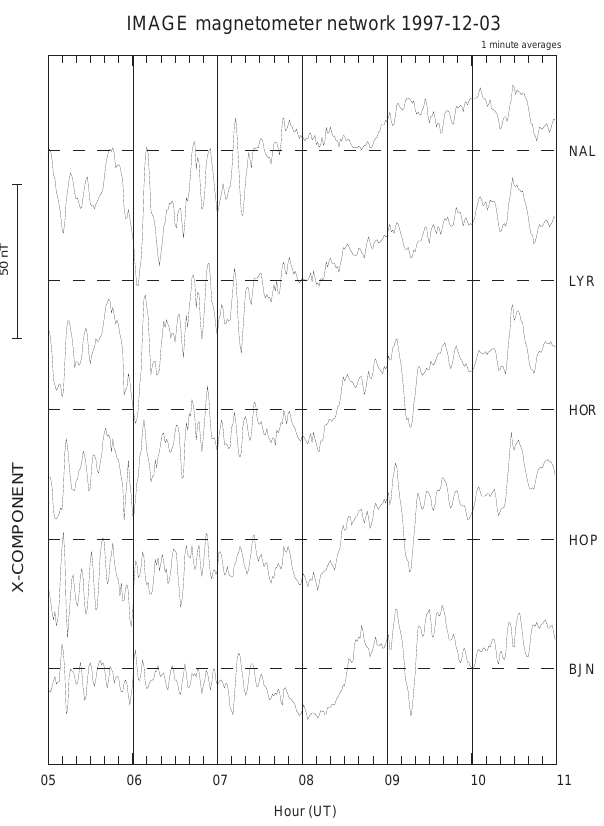
Figure 12 Fig. 12. X component magnetic deflections from the Svalbard IM- AGE stations, spanning the latitude range from 76 ◦ MLAT (NAL) to 71 ◦ MLAT (BJN). The interval shown is 05:00–11:00 UT on 3 De- cember 1997.